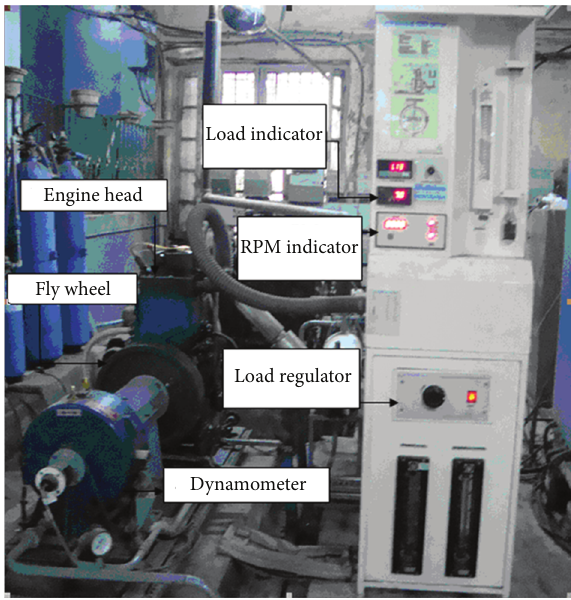
Figure 2: The engine assembly used for the experiment.